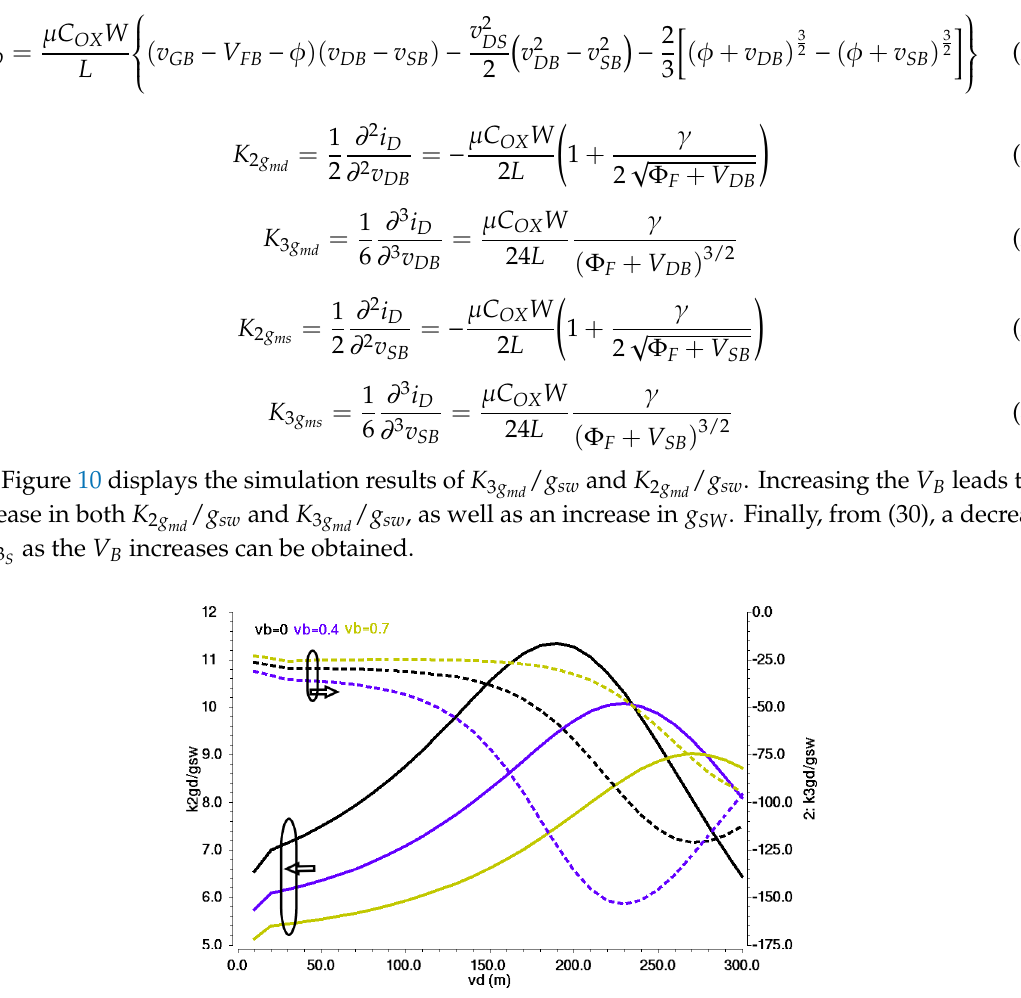
/ g sw and K 2 g / g sw md md